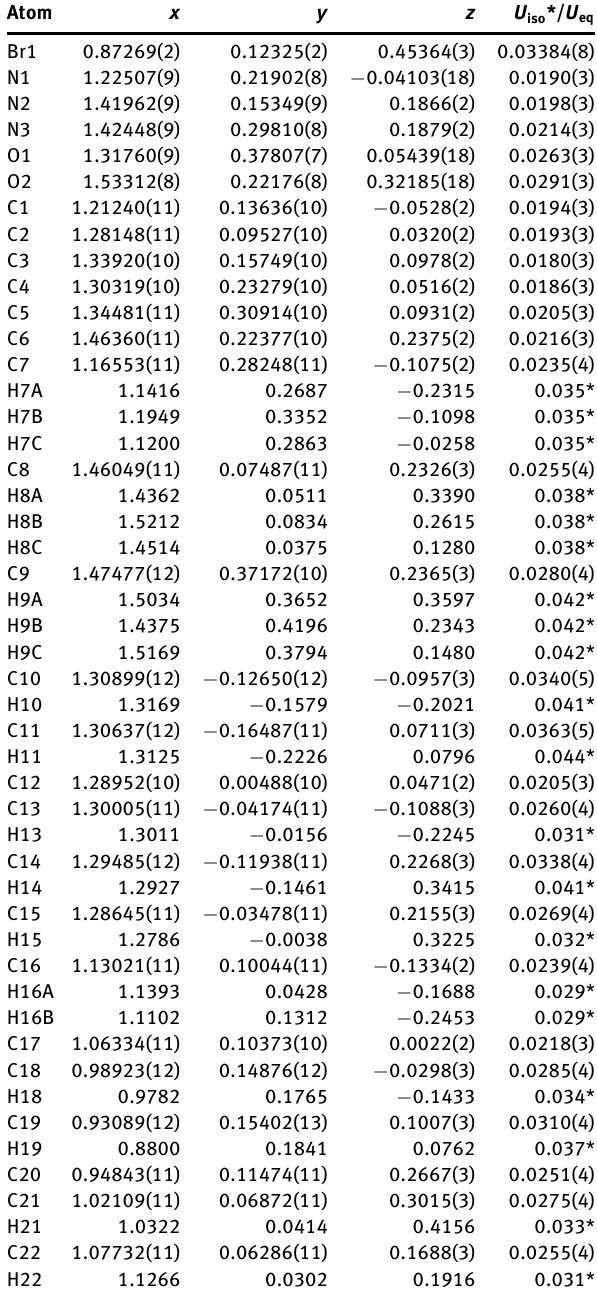
Table 2: Fractional atomic coordinates and isotropic or equivalent isotropic displacement parameters (Å 2